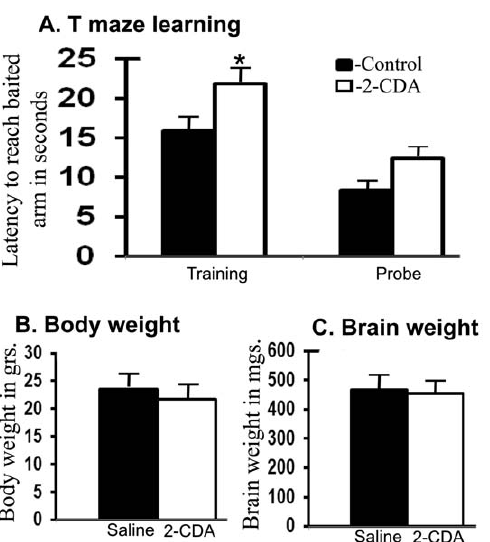
Figure 6. Chronic 2-CDA administration in mice delays reward- based learning in a T maze paradigm. (A) APdE9 mice treated with 2-CDA for 60 days by intraperitoneal injections from four-months of age to six months of age showed 38% (p , 0.05) delay in latency in acquiring food pellet-based learning task in the T maze. However, once the task was learnt, they no longer differed from controls in their retention of memory (probe). (B) Chronic 2-CDA administration did not alter the body weights or the brain weights (C). n=6 in each group. *, p , 0.05 versus controls by student t test.